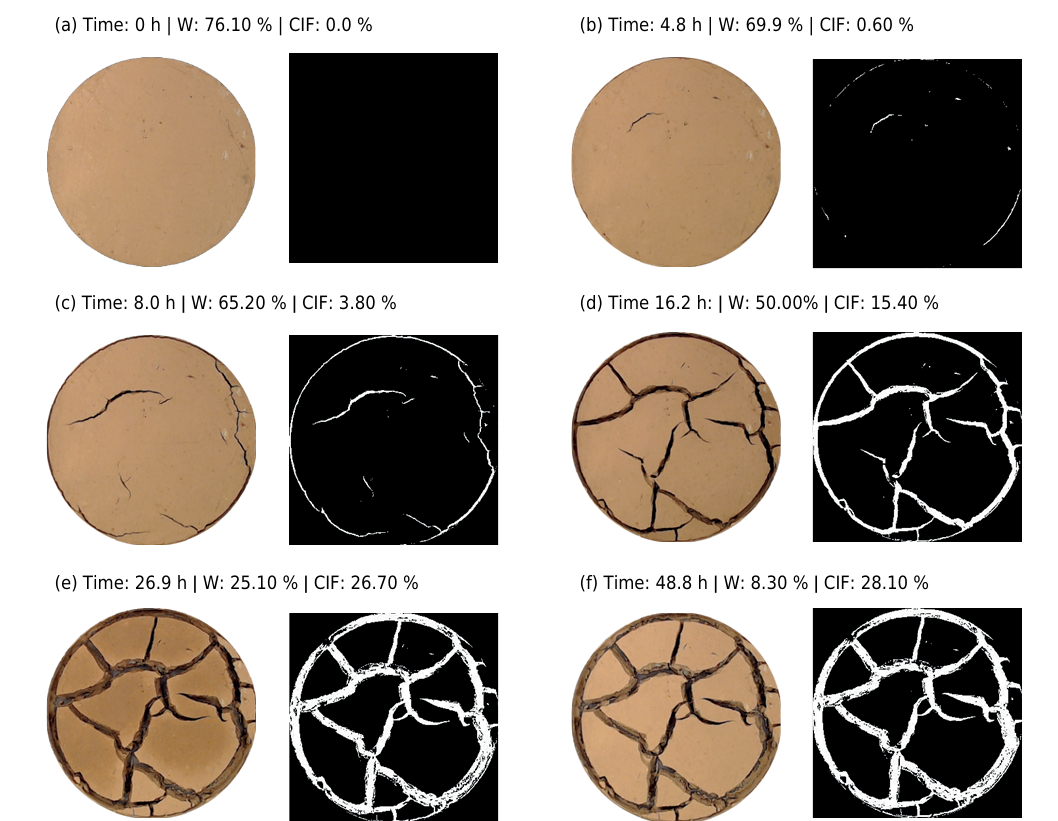
Figure 3. Process of crack development: Test 1 – W i = 76.1 %.